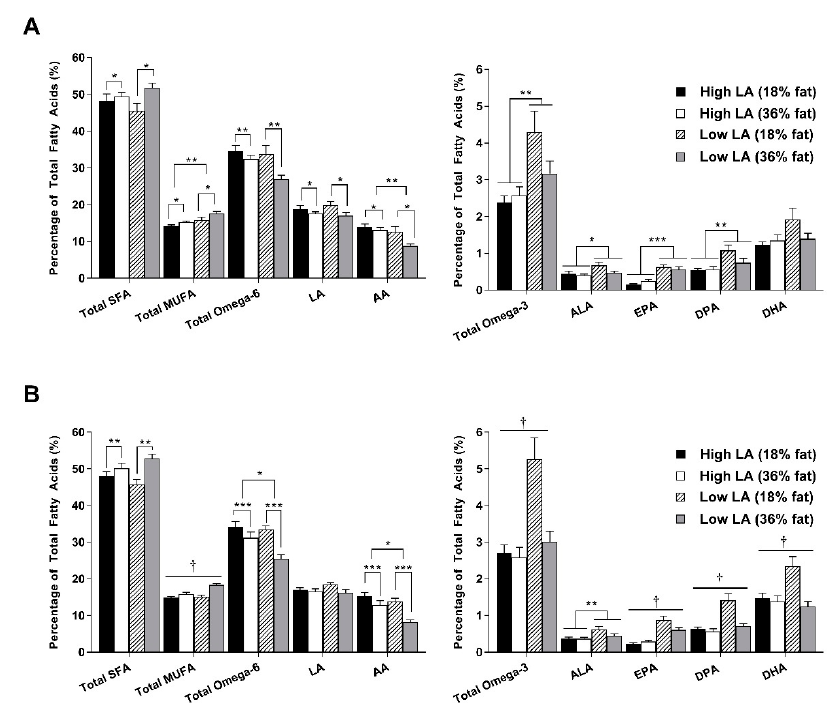
Figure 2. Whole blood fatty acid profile in ( A ) male and ( B ) female offspring at 4 weeks of age. Values are means ± SEM and n = 6–9 per group. The effects of maternal dietary fatty acid ratio and maternal dietary fat content were determined using a two-way ANOVA; all comparisons were made within sex group. * Indicates significant difference (* p < 0.05, ** p < 0.01, *** p < 0.001). † indicates a significant interaction effect ( p < 0.05). SFA, saturated fatty acid; MUFA, monounsaturated fatty acid; LA, linoleic acid; AA, arachidonic acid; ALA, alpha-linolenic acid; EPA, eicosapentaenoic acid; DPA, docosapentaenoic acid; DHA, docosahexaenoic acid.